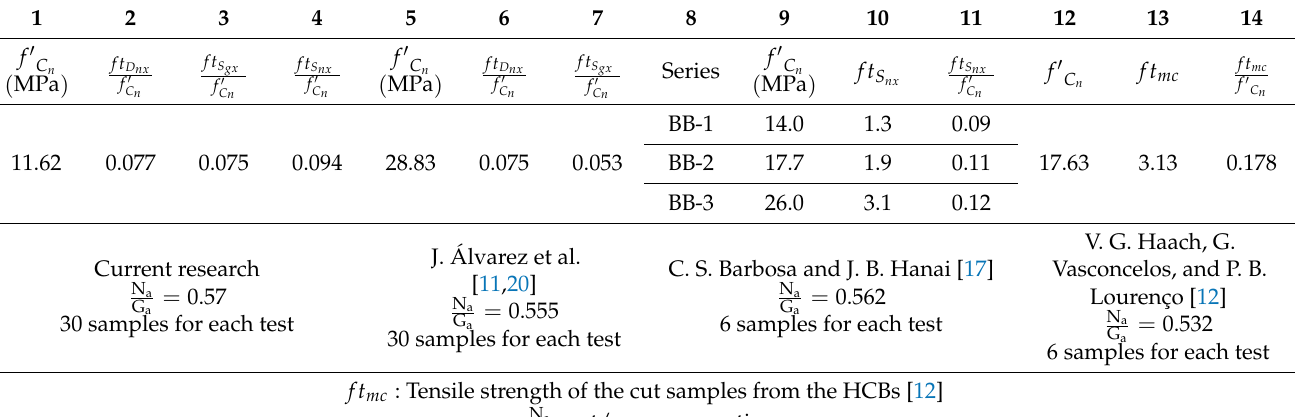
Table 4. Results comparison with other